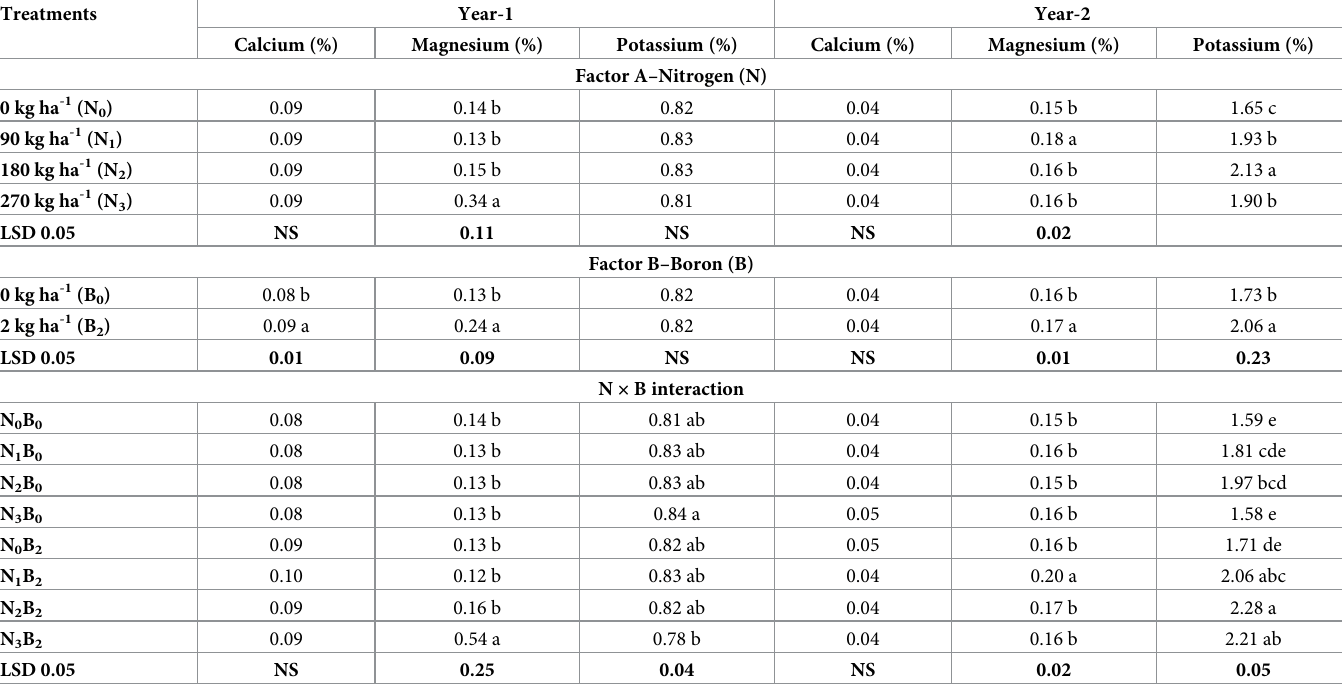
Means followed by similar letters within a column are statistically non-significant (p > 0.05). NS =